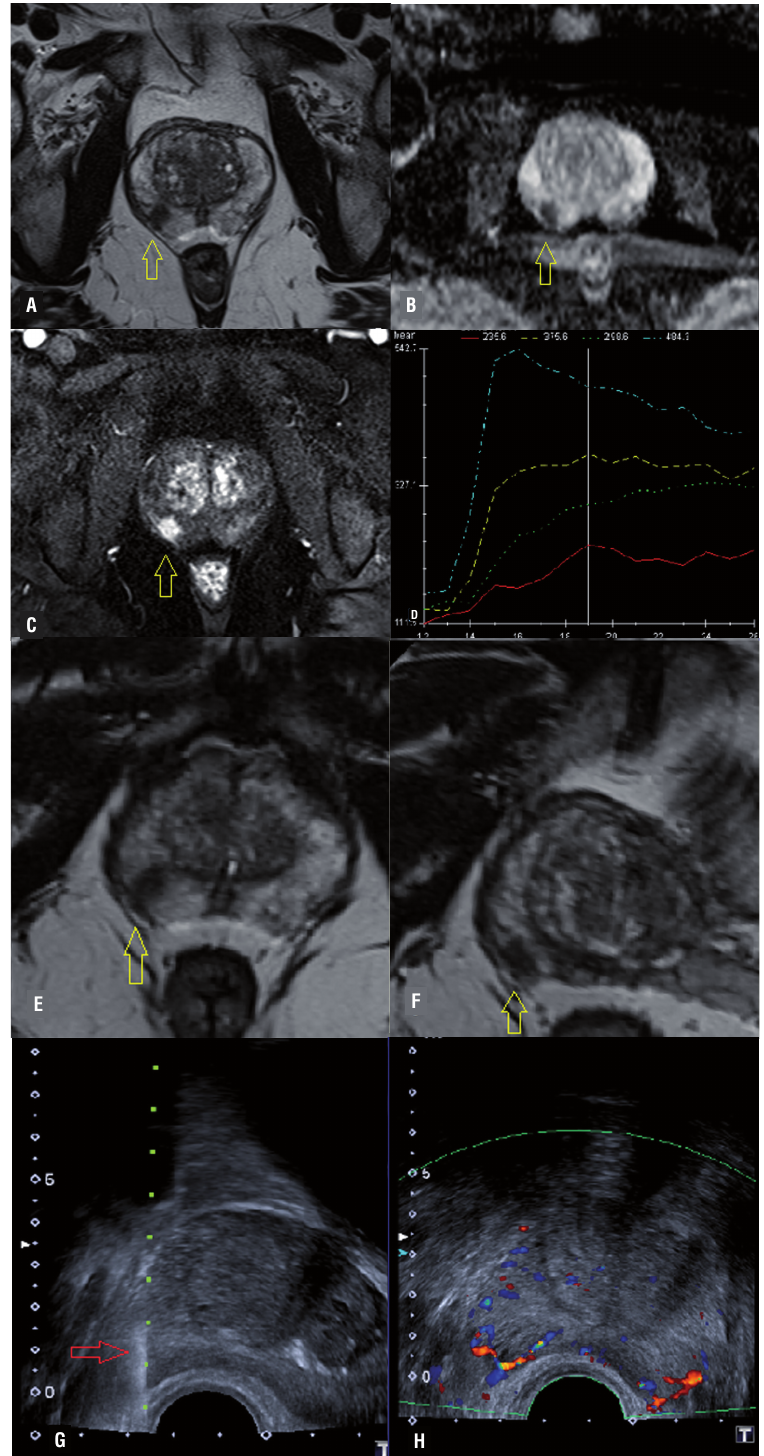
Figure 1 - MpMRI example of a suspicion lesion on the right lobe of peripheral zone of the prostate: A) a round lesion on T2 weighted-image; B) ADC map shows diffusion restriction; C) dynamic-contrast-imaging with hypervascularization and D) washout (blue line). Patient received US/MRI-guided biopsy where we can see the lesion on MRI (E and F) and in real time on US (G), helping to target the lesion